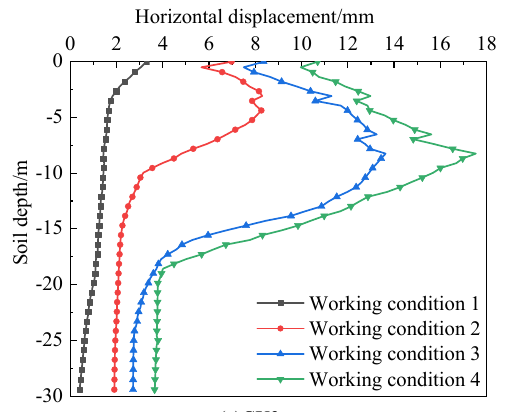
Figure 8. Horizontal displacement curve of the pile top.